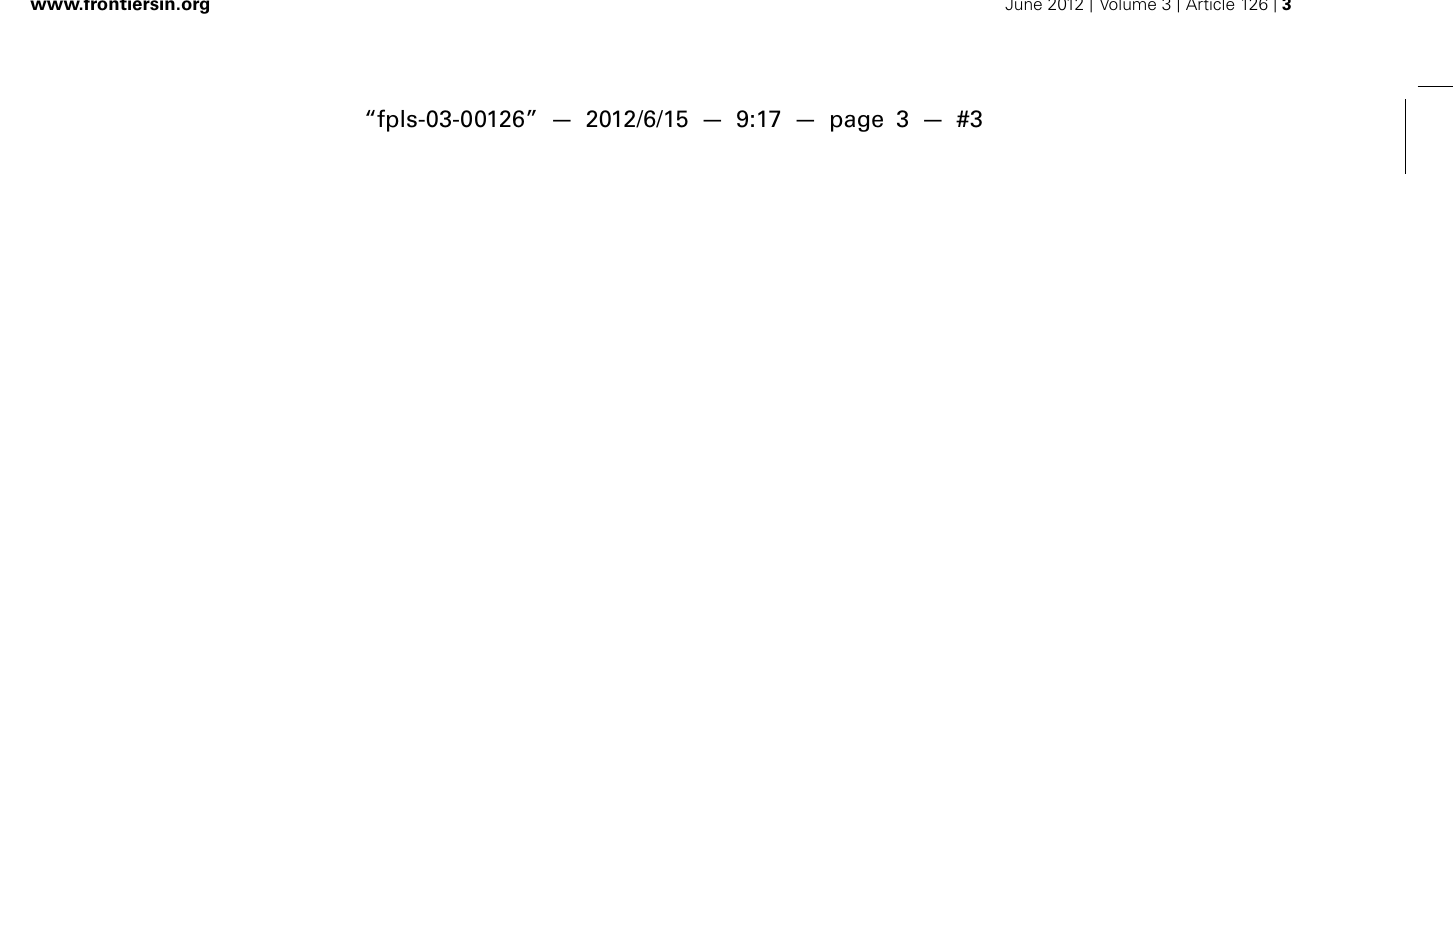
The slightly decreased clarity of images in (C) appears to result from the diffusion of PLA 2 α -RFP into the expanded apoplasts due to plasmolysis.White arrows in (C) indicate the plasmolyzed plasma membrane, whereas black arrows indicate extracellular spaces. Fluorescent (top), bright field (middle), and merged images (bottom) are presented. Bars = 20 μ